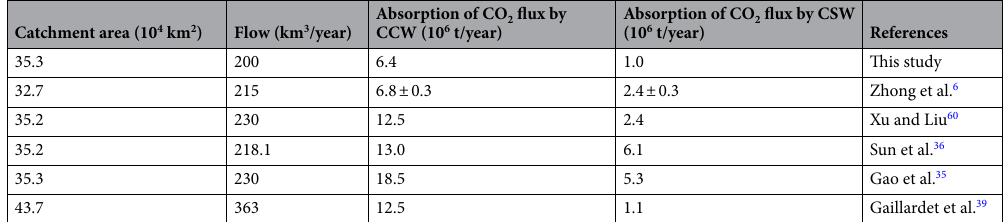
Table 11. A comparison of the results of this study with previous